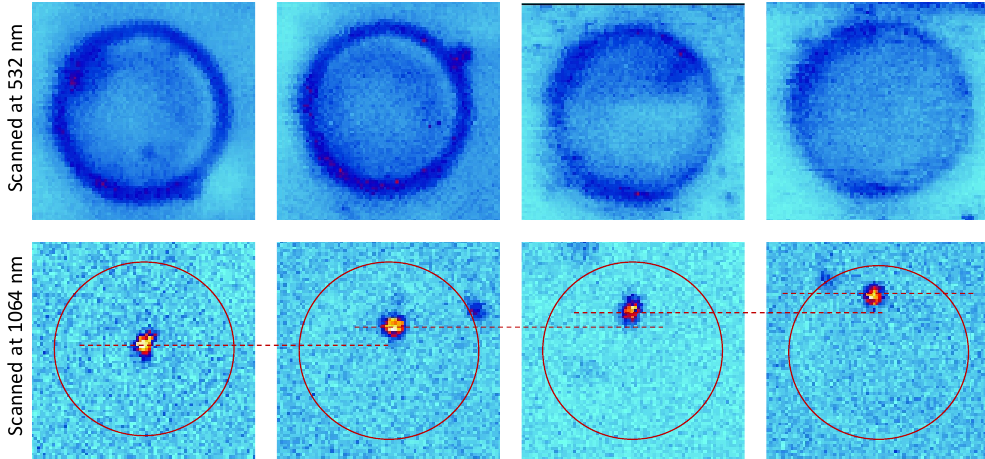
Figure 4. Top row : Fluorescence images of microdisk structures, obtained by scanning with a 532 nm cw laser. Bottom row : SH images of corresponding structures obtained by scanning with 1064 nm laser. The bright spots correspond to the SHG of KTP NPs, which are embedded at different positions of the microdisk, from center to edge. Scale bars: 1 µ